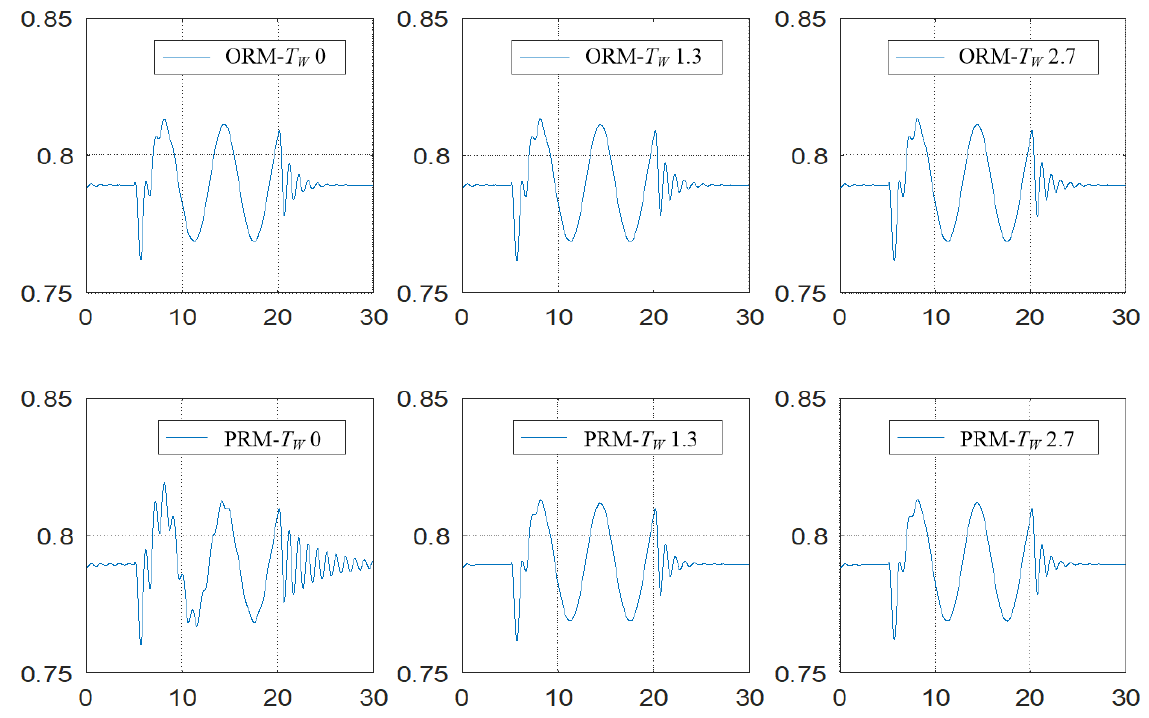
Figure 12. Response of power angle δ under voltage fluctuation.